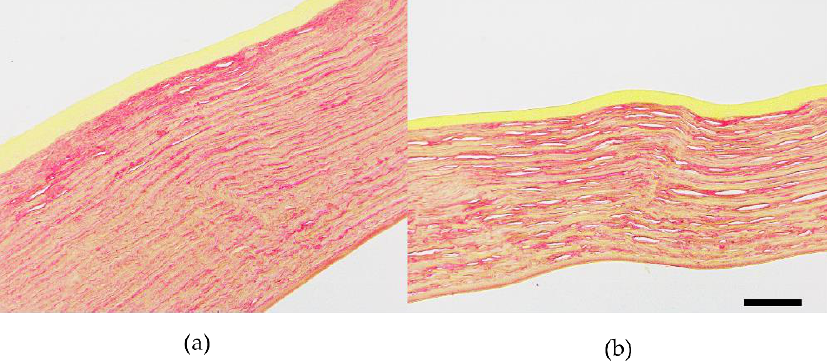
Figure 10. The Picrosirius red staining corneal sections of rabbits at 8 weeks. ( a ) normal cornea; ( b ) ectatic cornea (The scale bar is 100 μm).